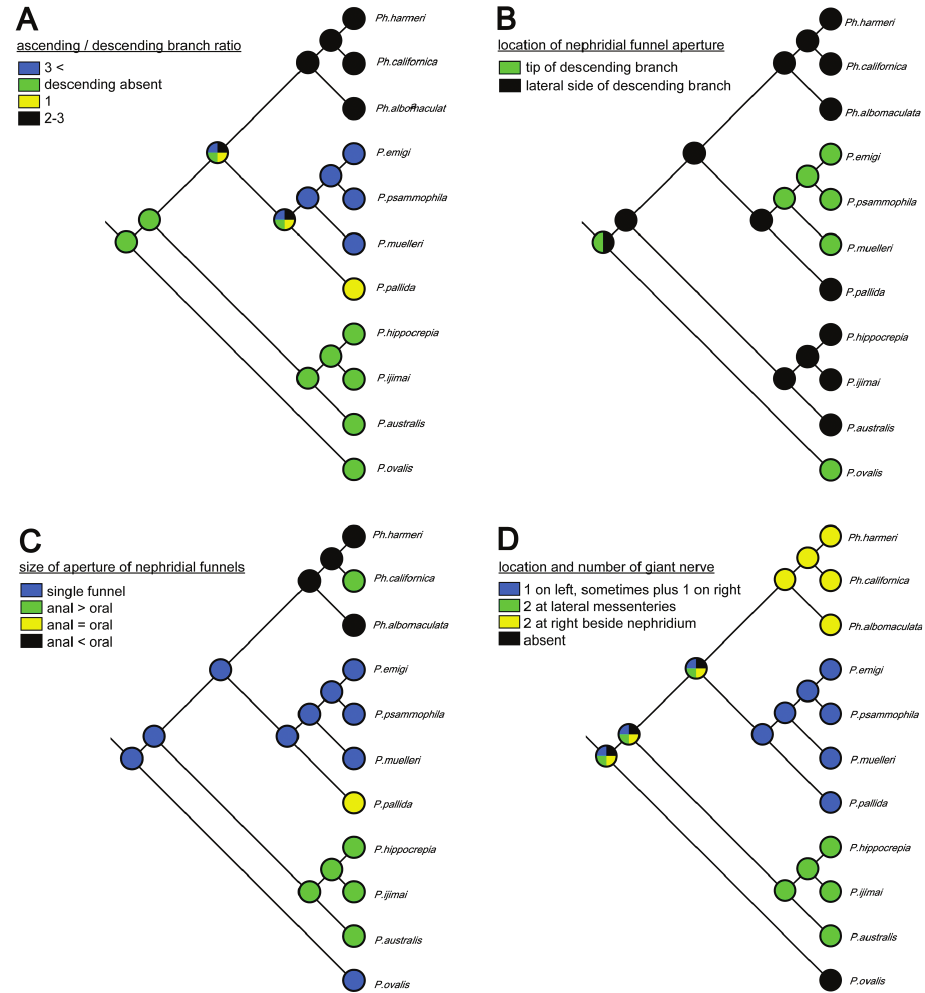
Supplementary Figure S3. Parsimonious reconstruction of four adult morphological characters among 11 phoronid species on the cladogram of the cluster analyses based on 32 morphological